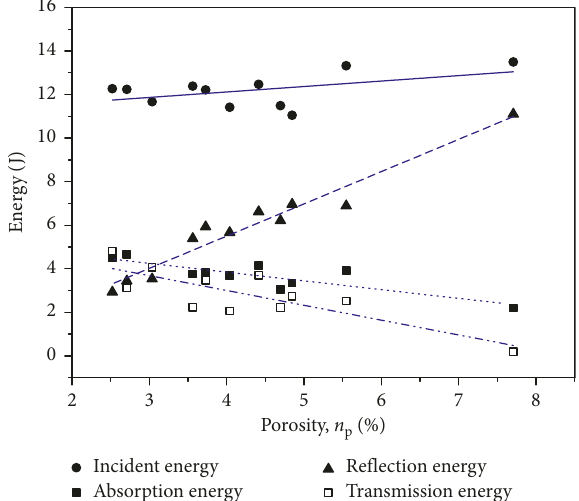
Figure 12: Relationship between porosity and